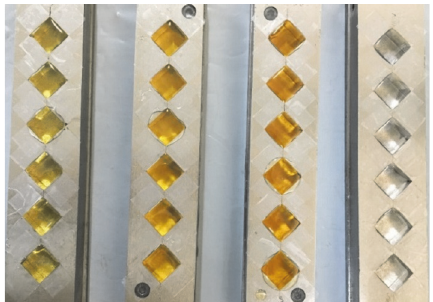
Figure 3: Specimens of transparent rock-like materials with different mass ratios. Table 1: The design for the USC test.